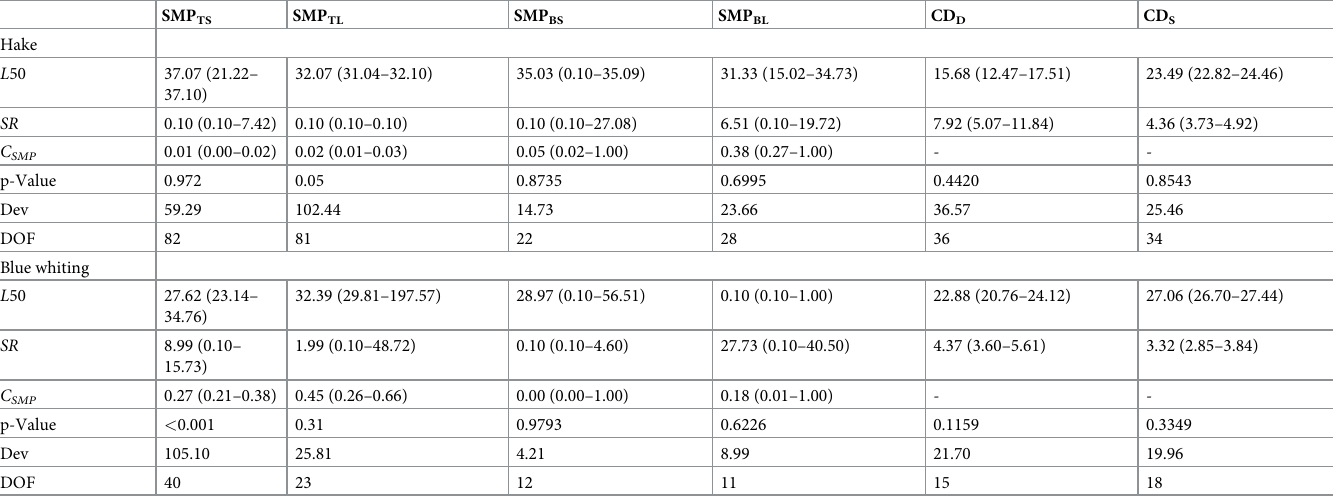
Table 1. Selectivity parameters for hake and blue whiting for the different SMP and codend designs considered in the